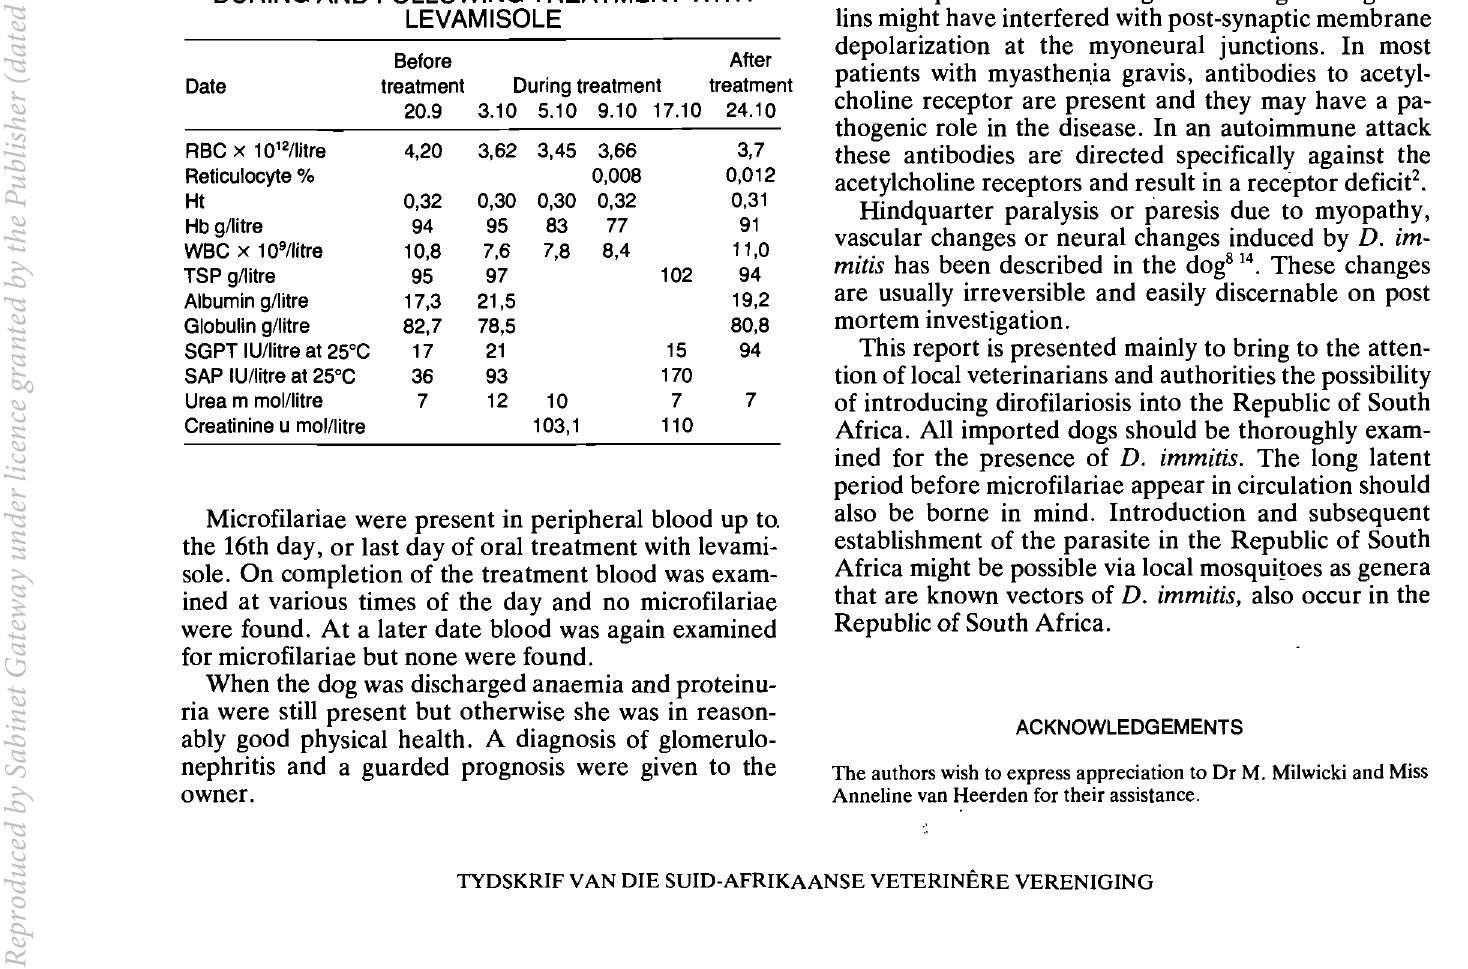
Table 2: RESULTS OF HAEMATOLOGICAL AND BLOOD CHEMISTRY INVESTIGATIONS BEFORE, DURING AND FOLLOWING TREATMENT WITH LEVAMISOLE Before